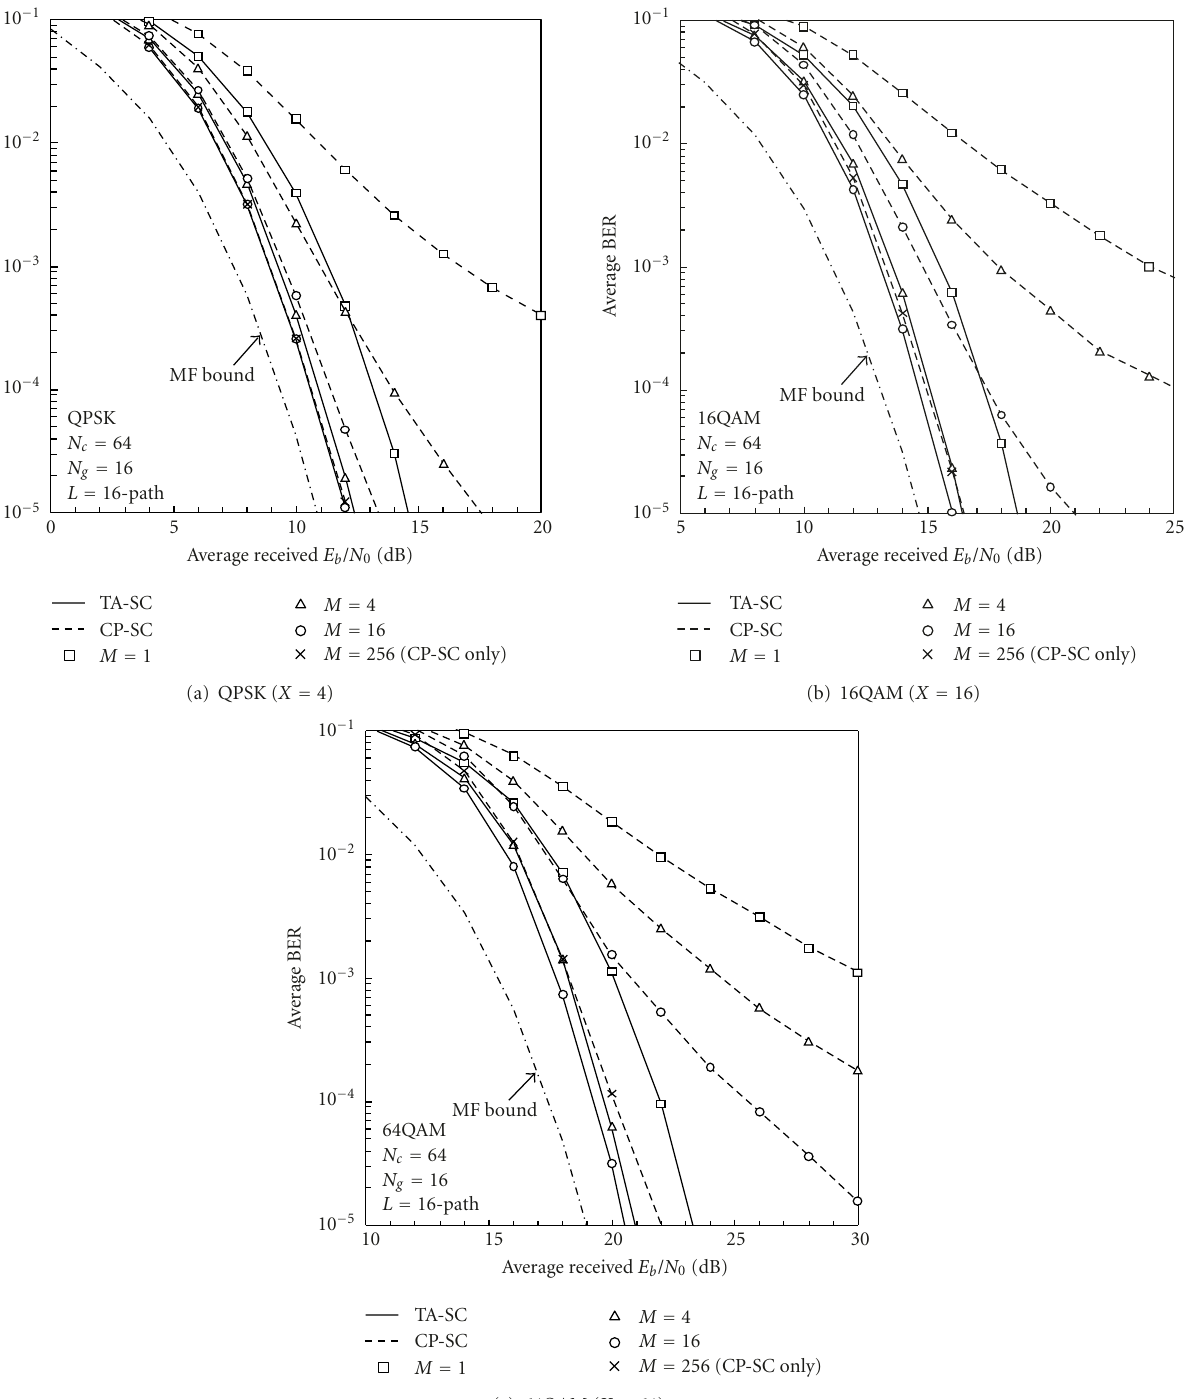
Figure 4: Average BER performance